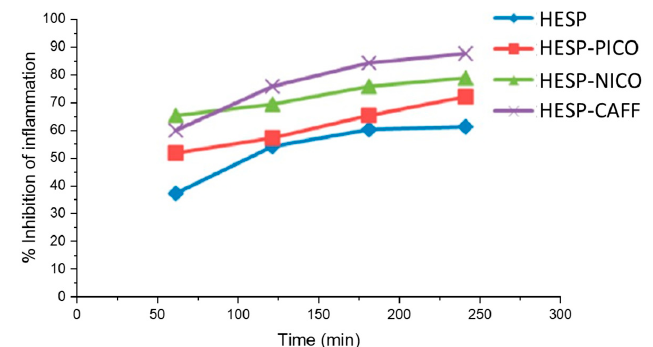
Figure 12. Percent inhibition of inflammation of HESP, HESP-PICO, HESP-NICO and HESP-CAFF. Adapted from [72] with permission. Copyright © 2017 American Chemical Society.